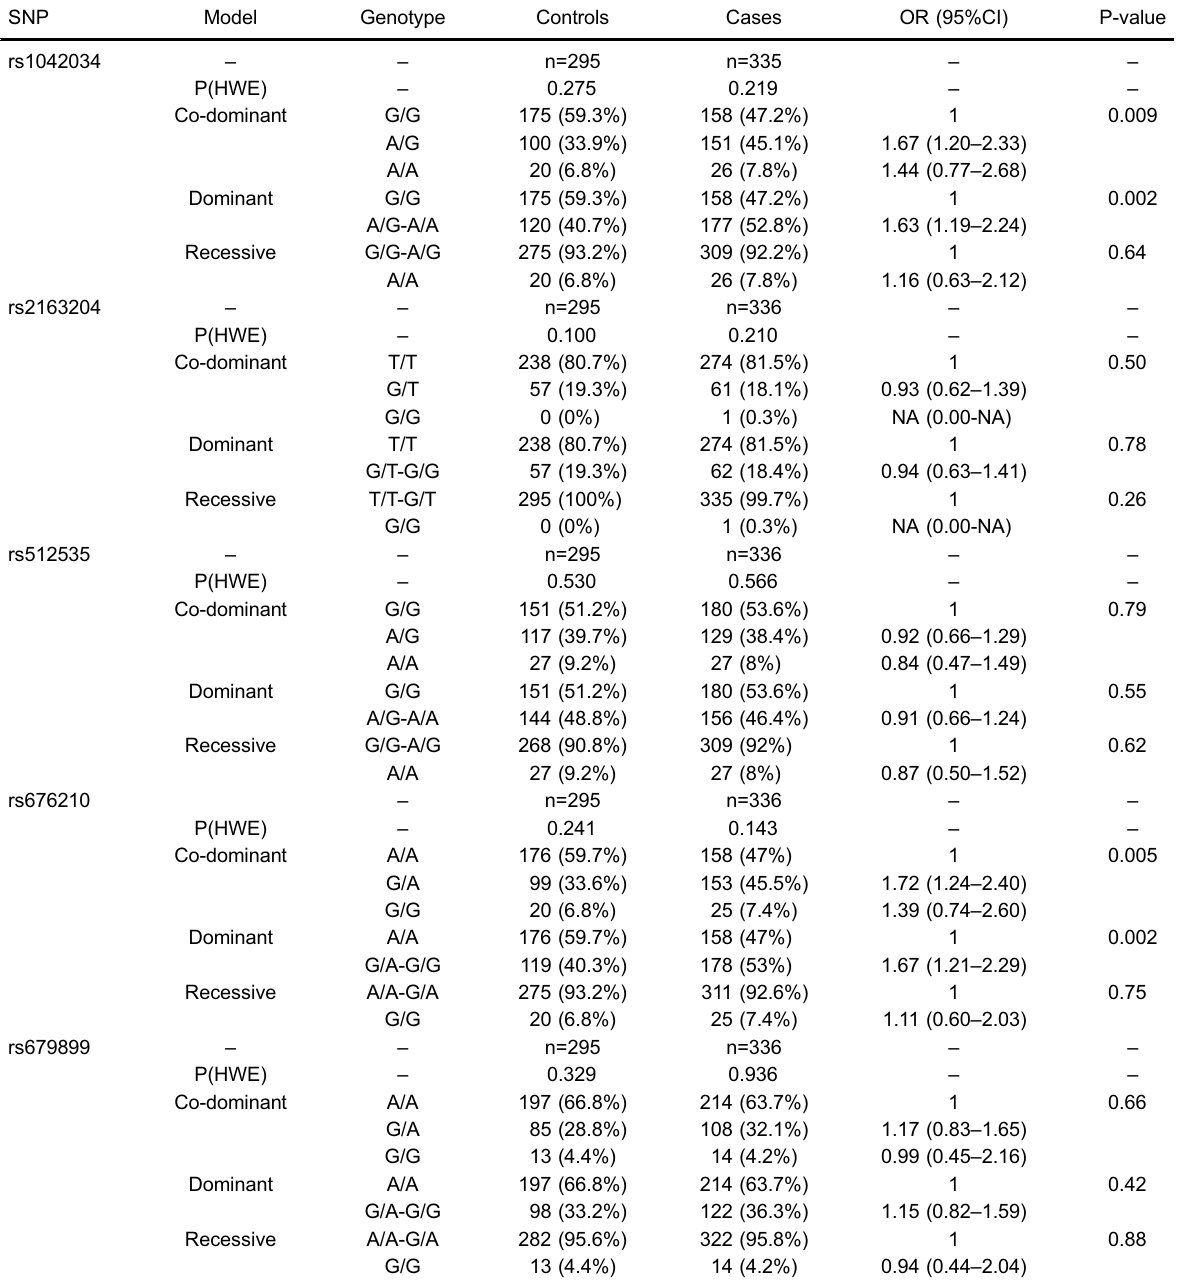
Table 2. Genotypic associations of fi ve SNPs with